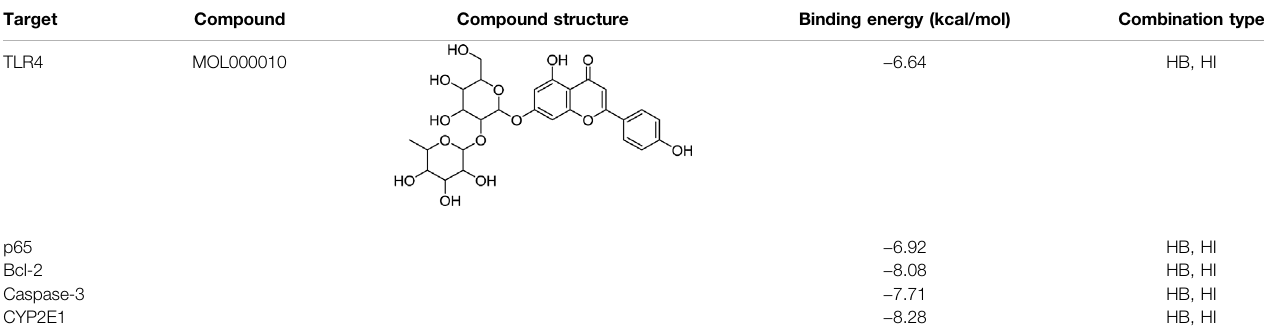
TABLE 2 | Target protein docking results for compounds.